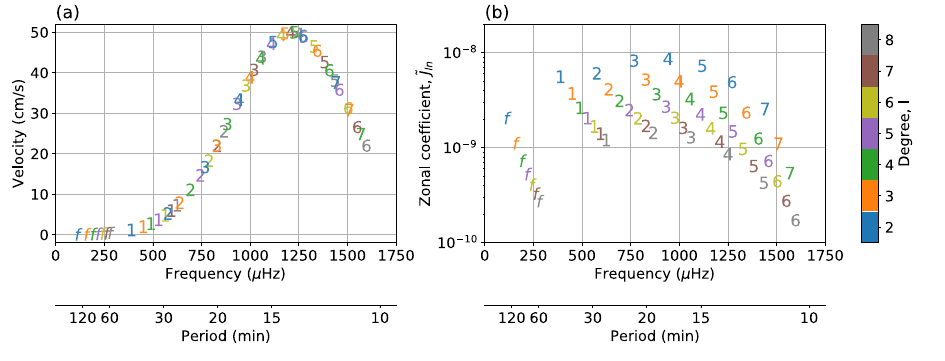
Fig. 2 | Normal modes model. Radial velocity pro fi le ( a ) and corresponding amplitudeofnormalizedsphericalharmoniccoef fi cients( b ).Themodelisdepicted